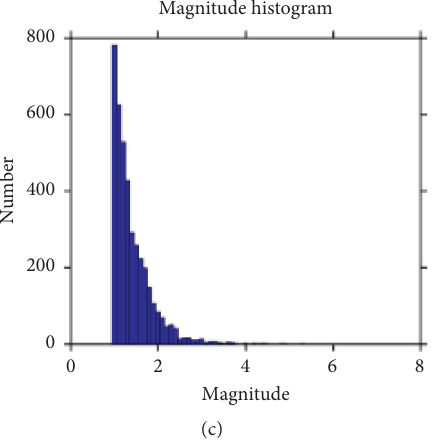
Figure 3: Earthquake statistics for the second reservoir head and adjacent areas: (a) small earthquakes; (b) depth; (c)